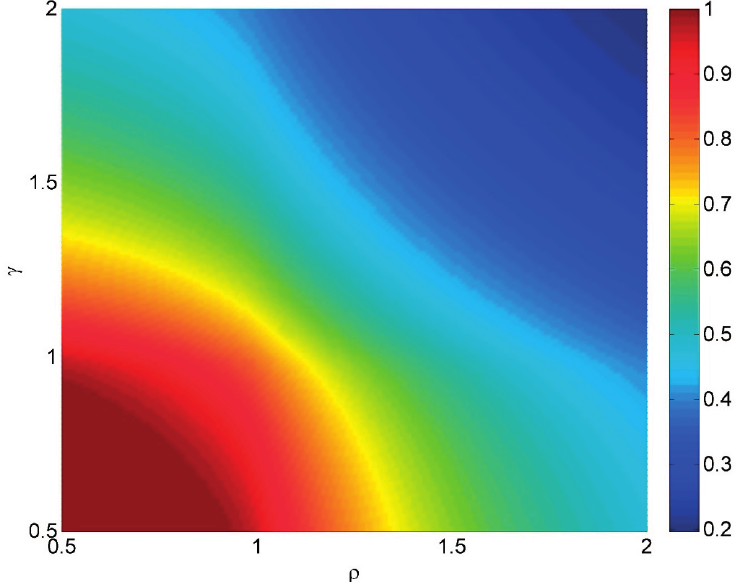
Figure 11. The dependence of fractional success rate h on the actuator spacing parameter ρ and the platform speed parameter γ . Colors range from blue for h = 0.2 to brown for h =